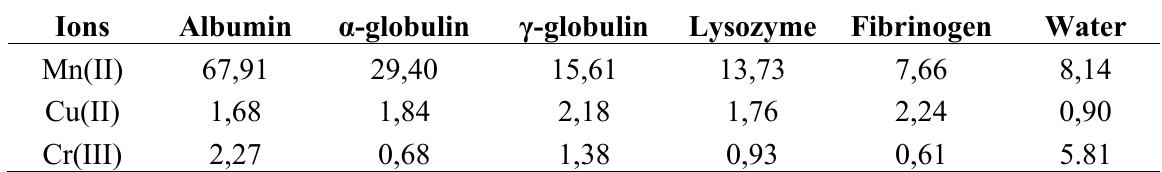
Table 1. The r values of the paramagnetic ions in solutions of albumin, α -globulin, γ - 1 globulin, lysozyme, fibrinogen and water.